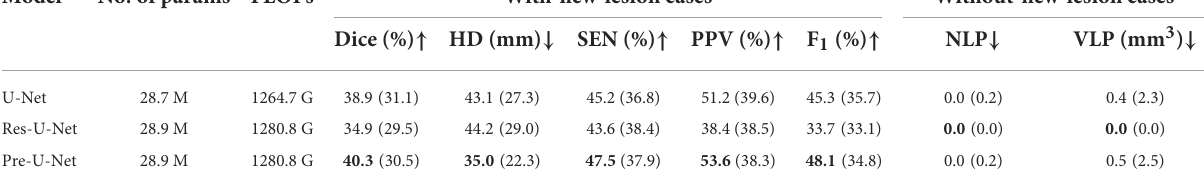
TABLE 3 Results on the MSSEG-2 test set.